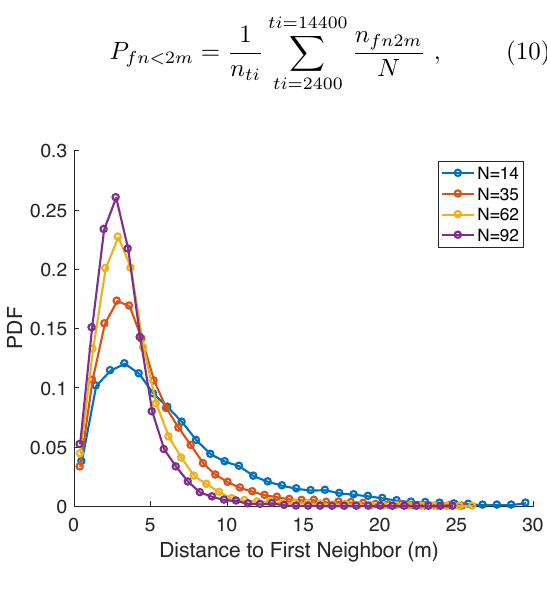
Figure 6: Probability density function of first neighbor